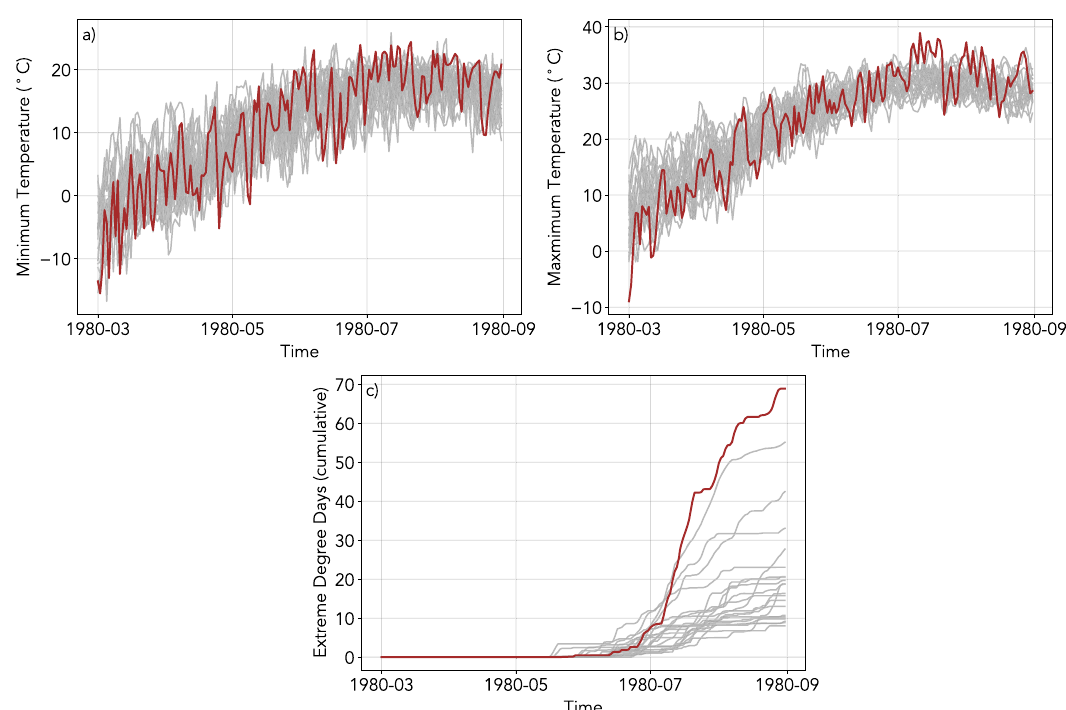
Fig. 4 Representative time series of historical temperature and extreme degree days. Daily time series of minimum temperature ( a ), maximum temperature ( b ), and the corresponding accumulation of extreme degree days ( c ) for a single representative grid point (40.375°N, − 88.875°E) in March through August 1980. This grid point falls within McLean County, Illinois, which was the highest maize-producing county in the U.S. over 1956 – 2005. The NEX-GDDP model hindcasts are shown in gray and the observations in red.